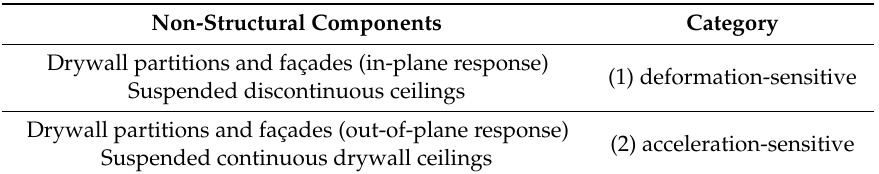
Table 2. Examples of classification of non-structural components based on the sensitive to the seismic